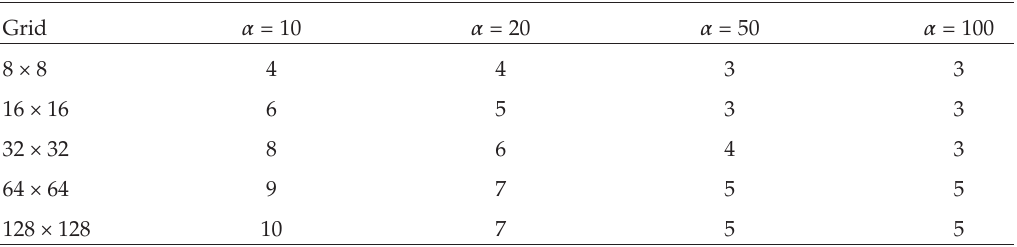
Table 2: Results for 2D unsteady Oseen problem di ff erent values of α (cid:5) exact solves (cid:6) and ν (cid:7) 0 . 05. Grid α (cid:7) 10 8 × 8